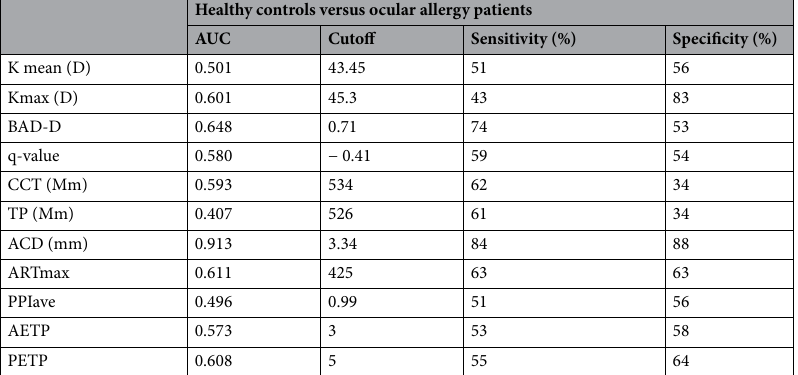
Healthy controls versus ocular allergy patients AUC Cutoff Sensitivity